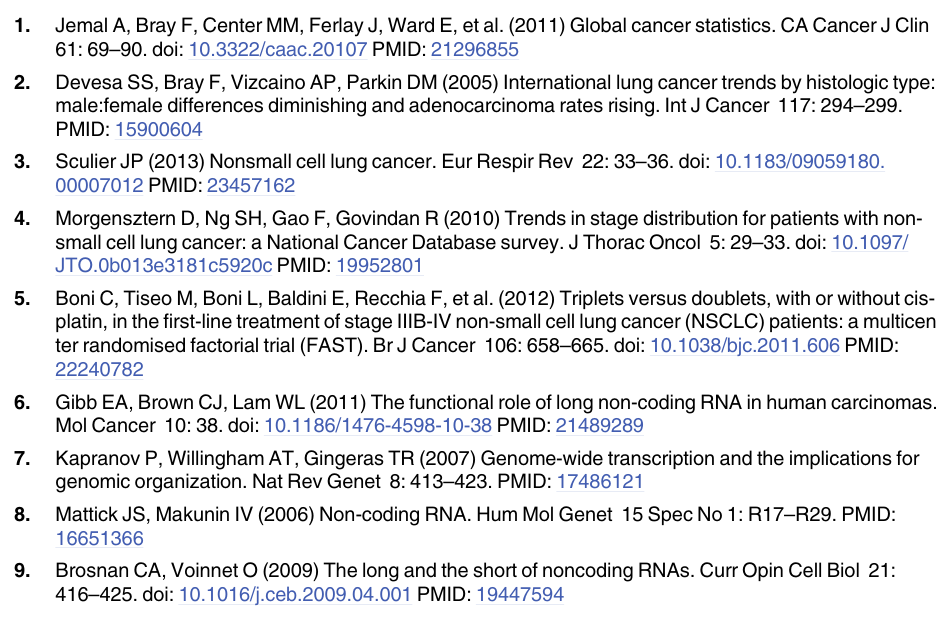
S1 Table. Association between MEG3 level and clinicopathological features of LAD patients (sensitive e group and insensitive group). There was no significant association between path- ological features and MEG3 expression level of LAD patient